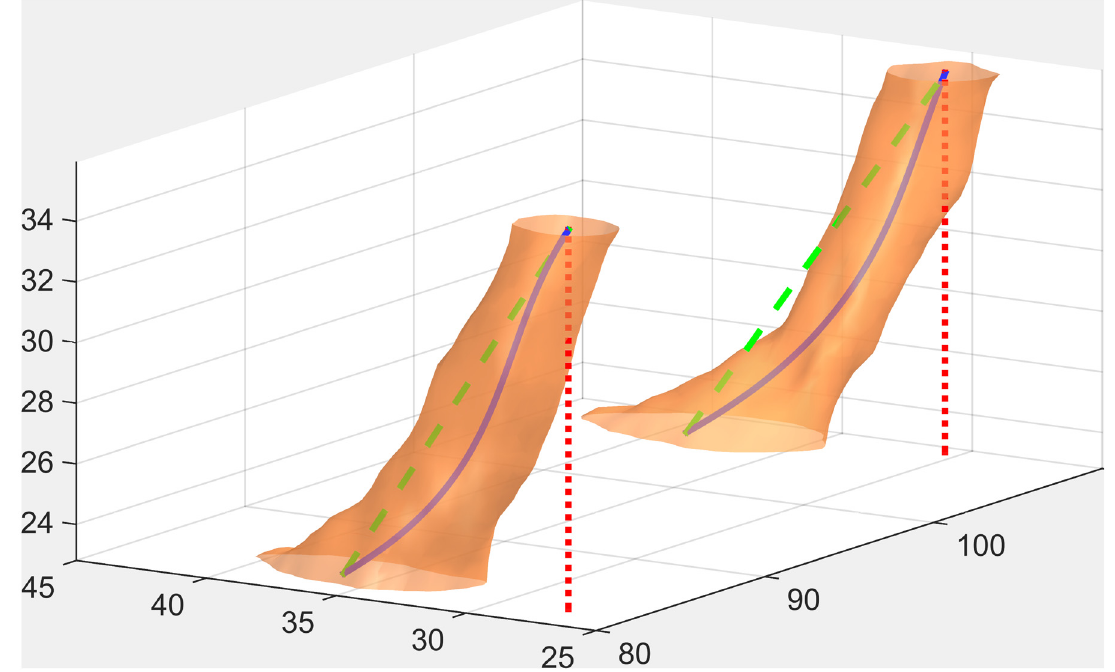
Fig 1. Different evaluations of NLC length: axial (dotted red line), end-to-end (dashed green line) and true (continuous blue line).